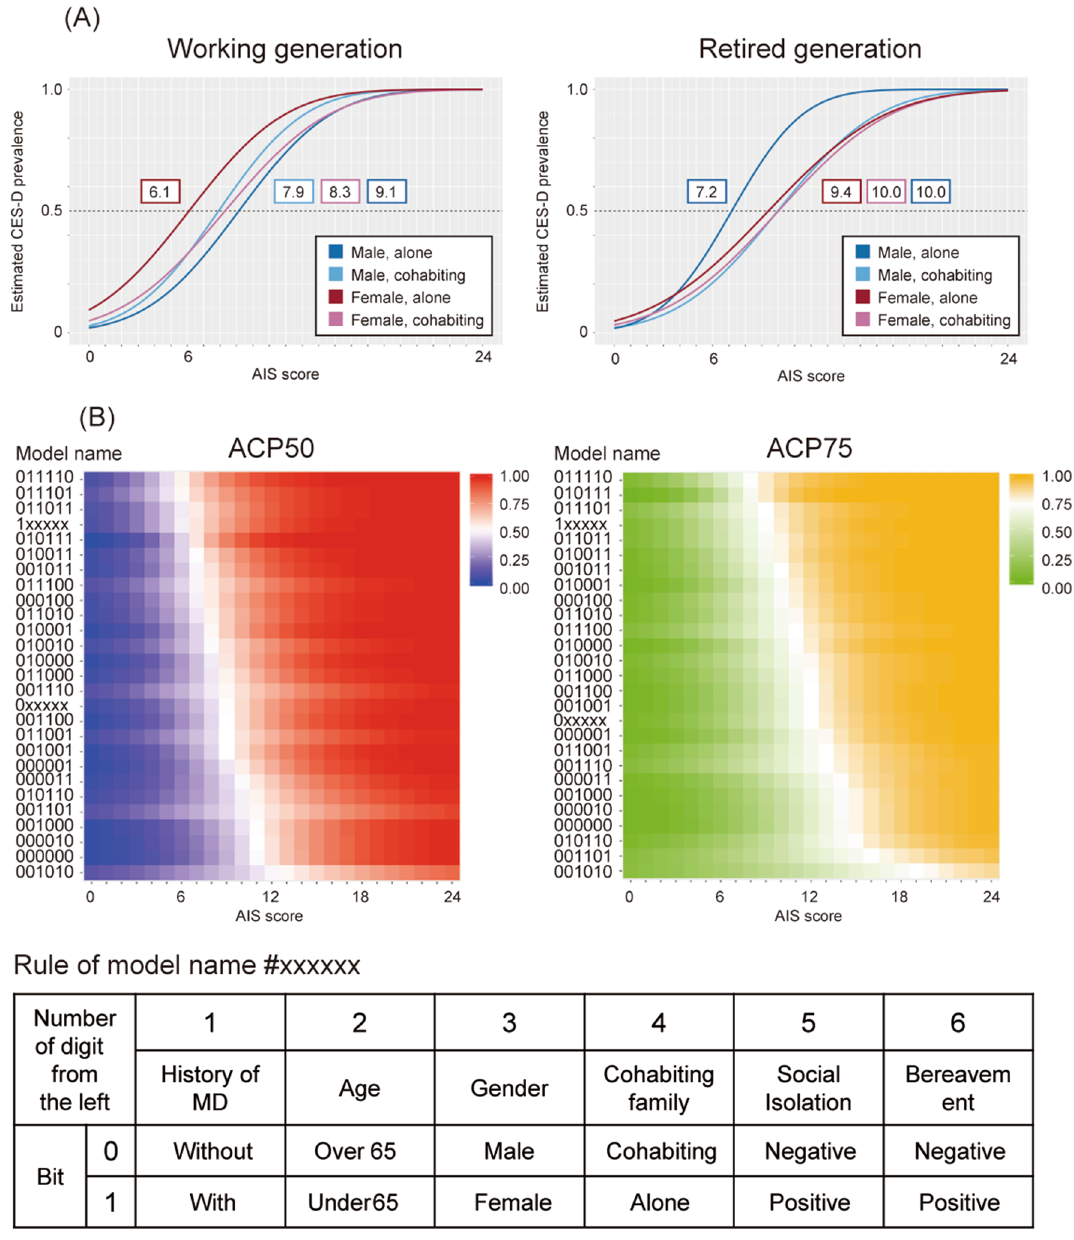
Figure 2. Probit regression models of estimated prevalence of Center for Epidemiologic Studies Depression (CES-D) score stratified by multiple risk factors for depression. ( A ) Graphs of estimated prevalence models P (CES-D positive | AIS = x, mental disorder = 0, stratified by age, sex, and cohabiting family). The graph representing the working generation is shown on the left, while the same for the retired generation is presented on the right. The ACP50 value of each subgroup is shown in the color frame. ( B ) Heatmaps of estimated prevalence models P (CES-D positive | AIS = x, mental disorder = 0, stratified by age, sex, cohabiting family, social isolation, and bereavement). The horizontal axis of the heatmaps in each panel indicates the AIS score, and names of each model are depicted along the left axis of each heat map. The spectra arranged in ascending order by ACP50 and ACP75 values are shown on the left and right graphs, respectively. For comparison, the spectra of the subgroups with and without MD are also presented in Fig. 1 (1xxxxx and 0xxxxx,